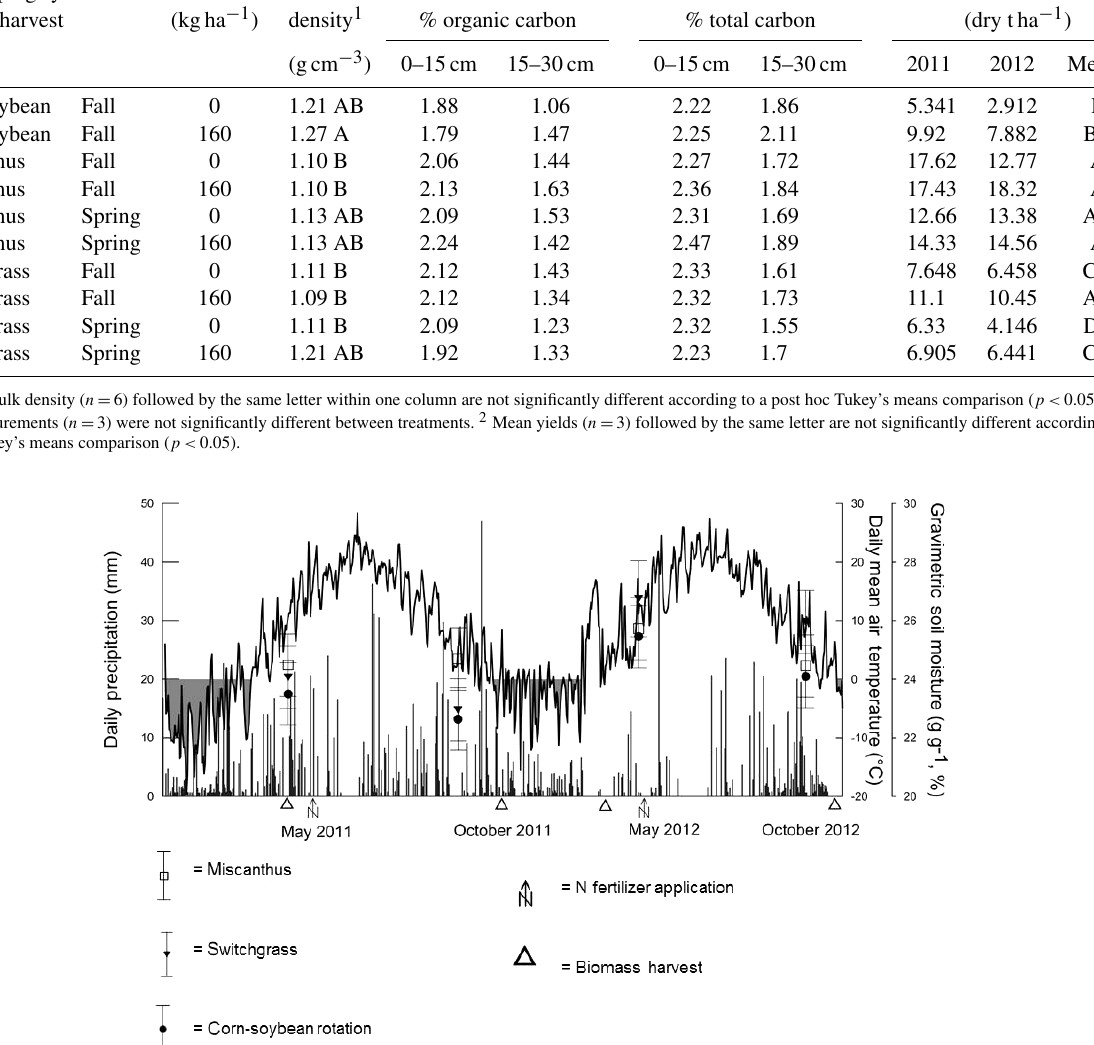
Table 1. Mean soil properties measured at the Elora Research Station. Cropping system/